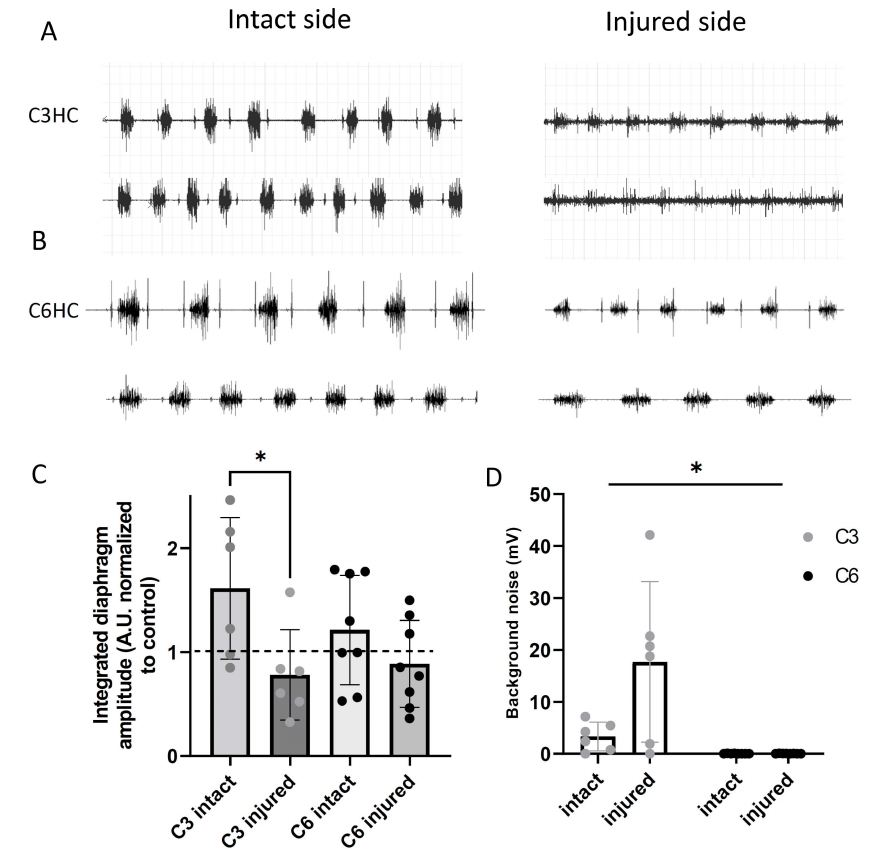
Figure 4. Diaphragm activity following C3 and C6 hemicontusions (HCs). Representative exam- ples of diaphragmatic EMG in two mice 7 days after C3 hemicontusion ( A ) or C6 hemicontusion ( B ) and mean +/ − SD in each group of animals ( C ). Amplitude recordings of 2 inspiratory interbursts and of the ECGs in injured and intact sides after C3 and C6 hemicontusions ( D ) * p < 0.05.